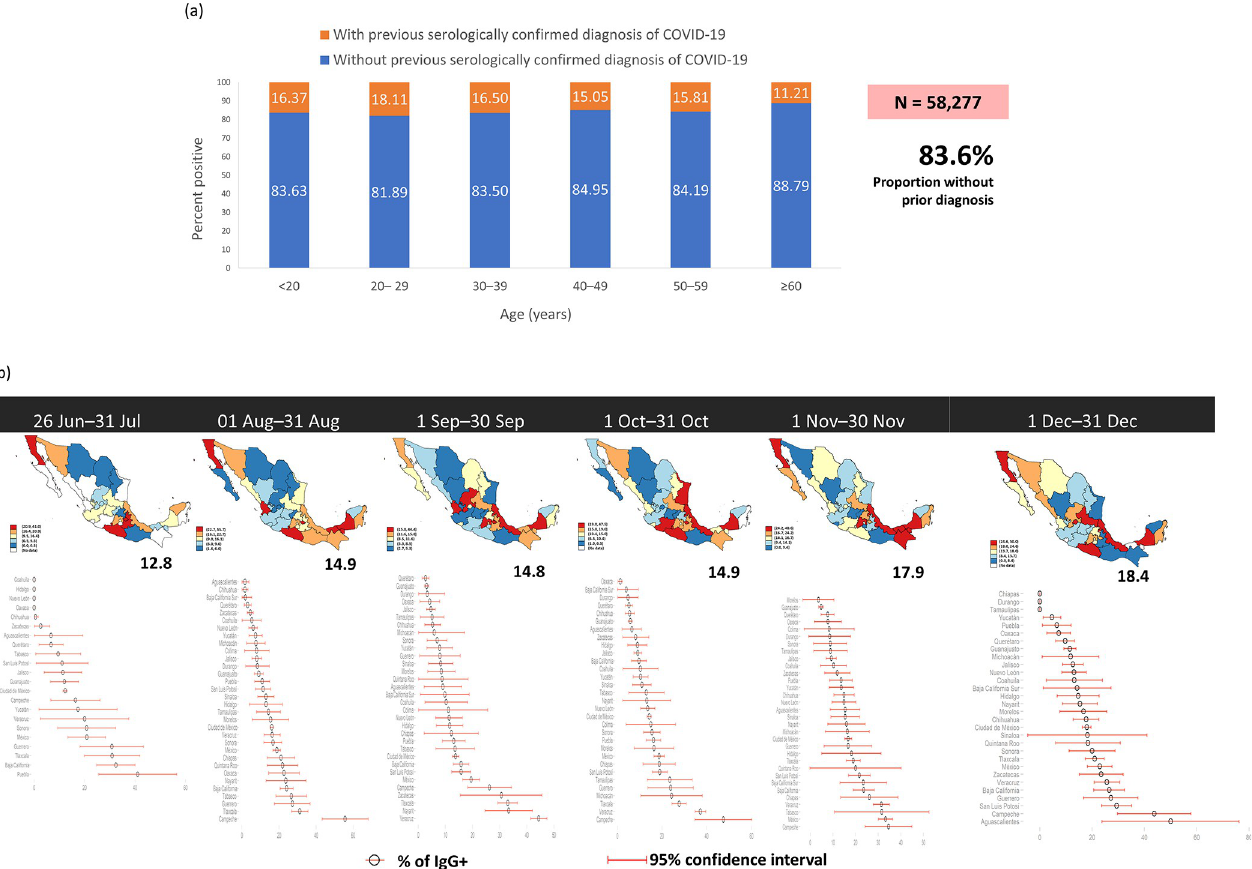
Fig 3. Proportion of IgG-positive tests according to previous diagnosis of COVID-19, stratified by age group (a), and monthly rates of IgG-positive tests according to Mexican state from June 26 to December 31, 2020 (b). States are colour-coded by quintile and data are the proportion of positive IgG test results with 95% confidence